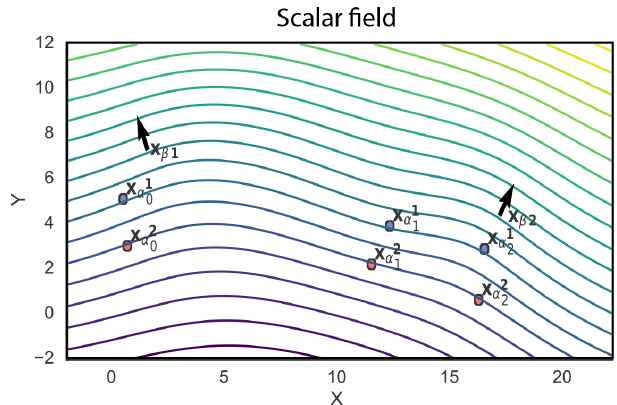
Figure 2. Example of scalar field. The input data are formed by six points distributed in two layers ( x 1 ( x β j ). An isosurface connects the interface points and the scalar field is perpendicular to the foliation